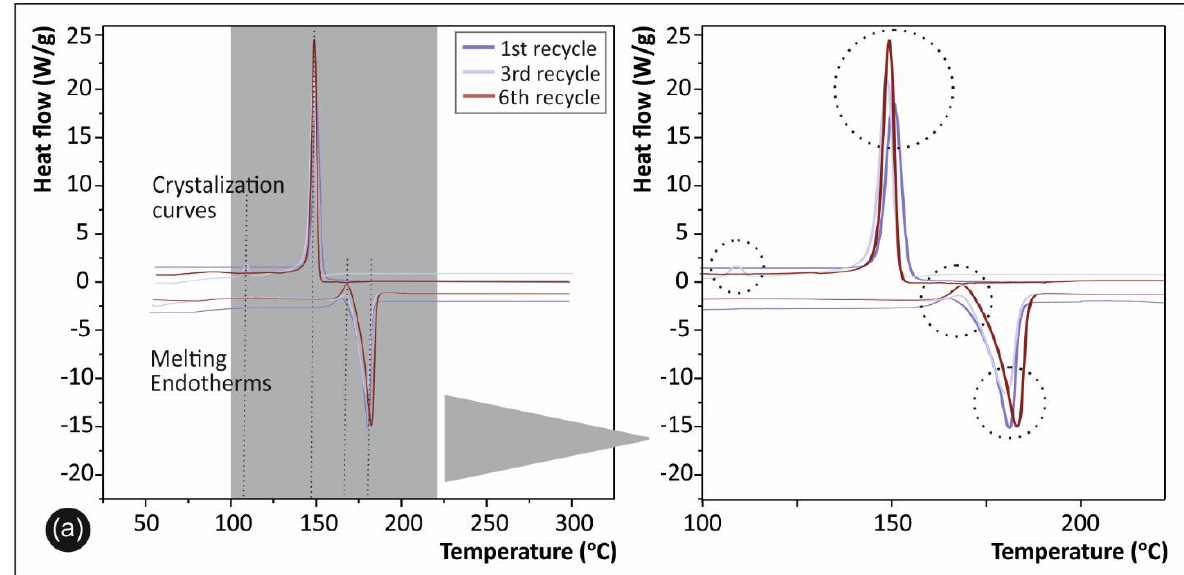
Figure 9. ( a ) DSC 2nd heat/cool cycle curves for PA12 1st, 3rd, and 6th recycling courses and ( b ) magnified temperature window of the DSC curves. Table 1. Basic thermal characteristics of the PA12 samples as obtained and calculated from DSC results. Sample